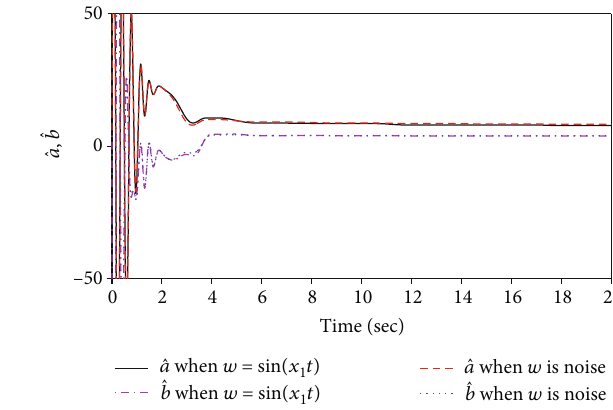
Figure 7: Time response of the parameter estimates.